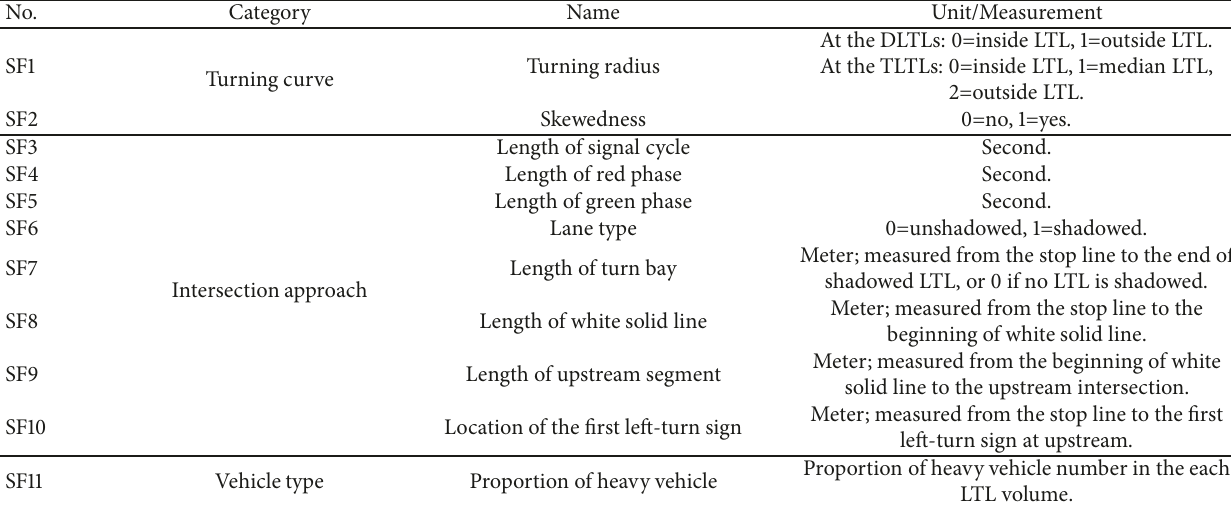
Table 2: Static influential factors of the LTL usage.